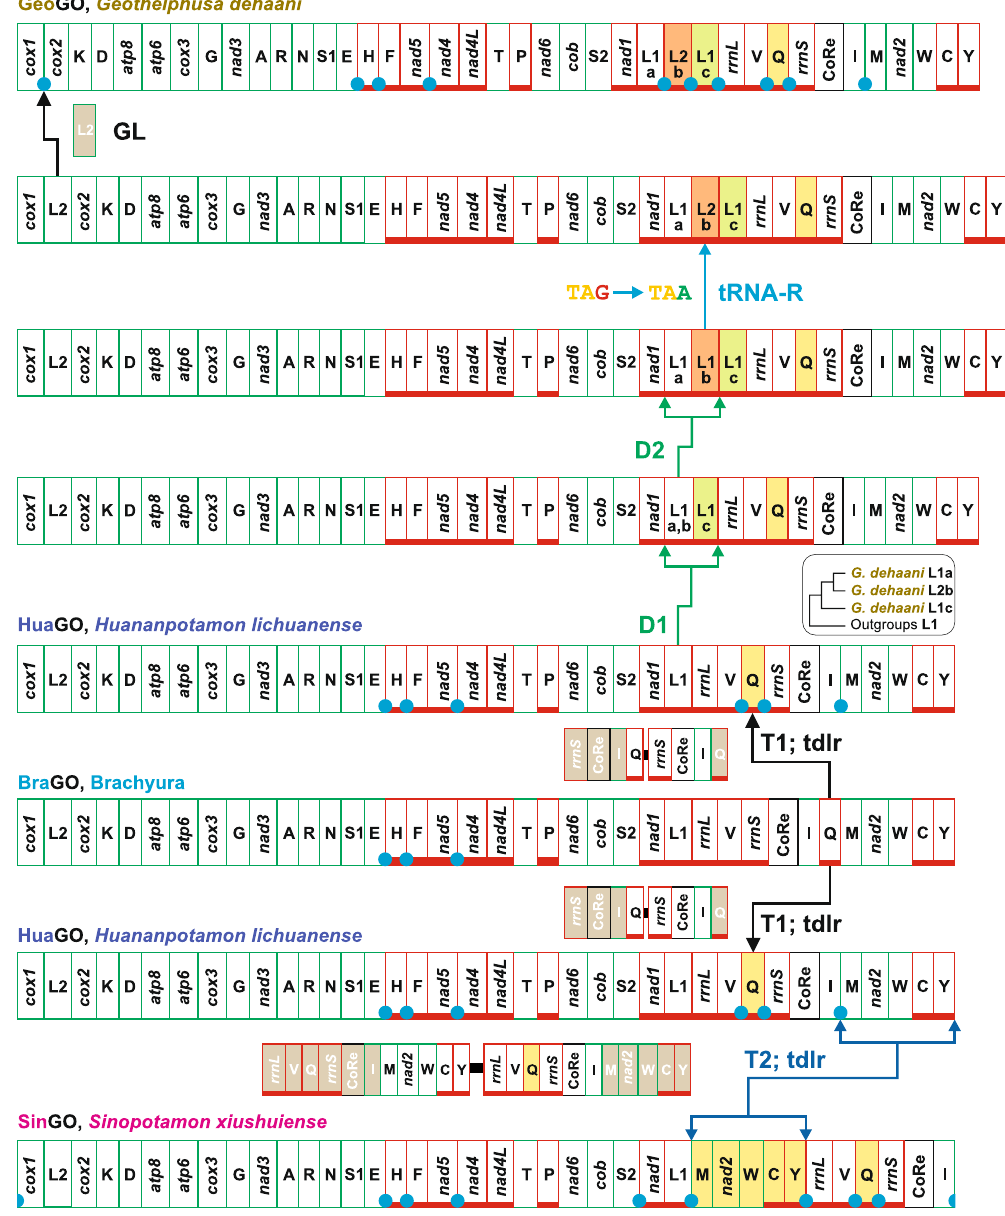
Figure 6. The evolution of GOs in Potamid crabs. Transformational pathways generating GeoGO, HuaGO and SinGO. The rearrangements in the GOs of Potamid species are investigated and depicted with respect to BraGO. T1-T2, transposition events; tdrl, tandem duplication random loss mechanism producing the observed rearrangement; D1-D2, gene duplication events; tRNA-R, tRNA remoulding event; GL, gene loss event. The genomic and genetic nomenclature, as well as the colour scheme, are the same as in Fig. 1. The genes that changed their position relative to PanGO, through a transposition event, are shown with a yellow background. The passively-shifted genes are figured with their original background. A blue circle marks an intergenic spacer present in a position associated to genomic